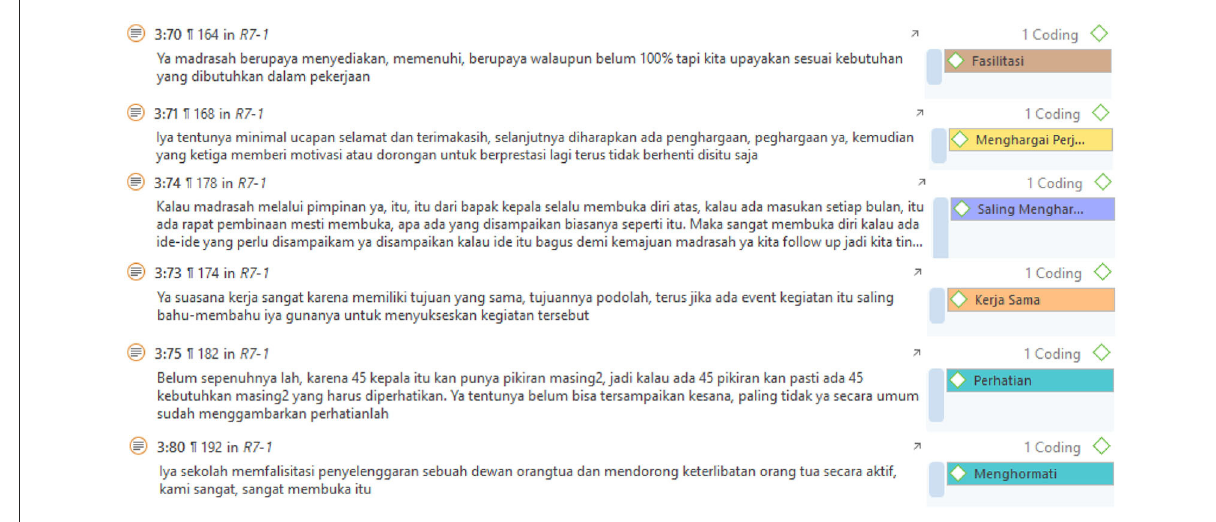
FIGURE3 Values in the culture and environment of MAN 2 boyolali.